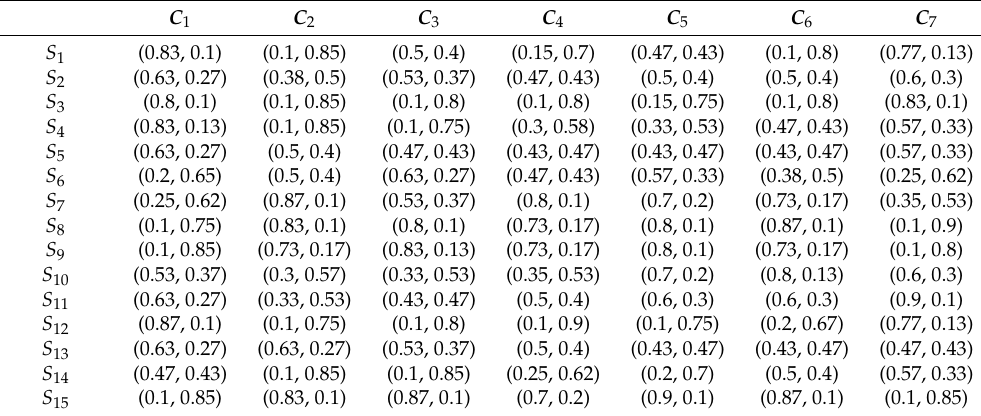
Table 5. The elements of the decision-matrix.